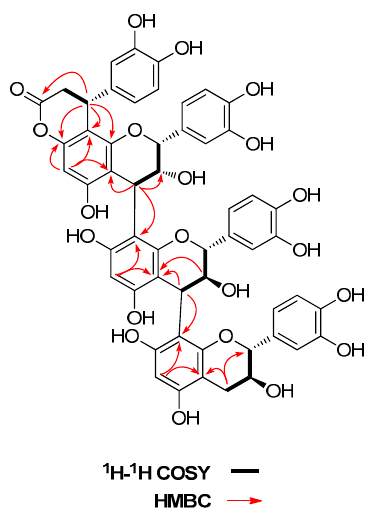
Figure 2. Key 1 H- 1 H COSY and HMBC correlations of 1 .